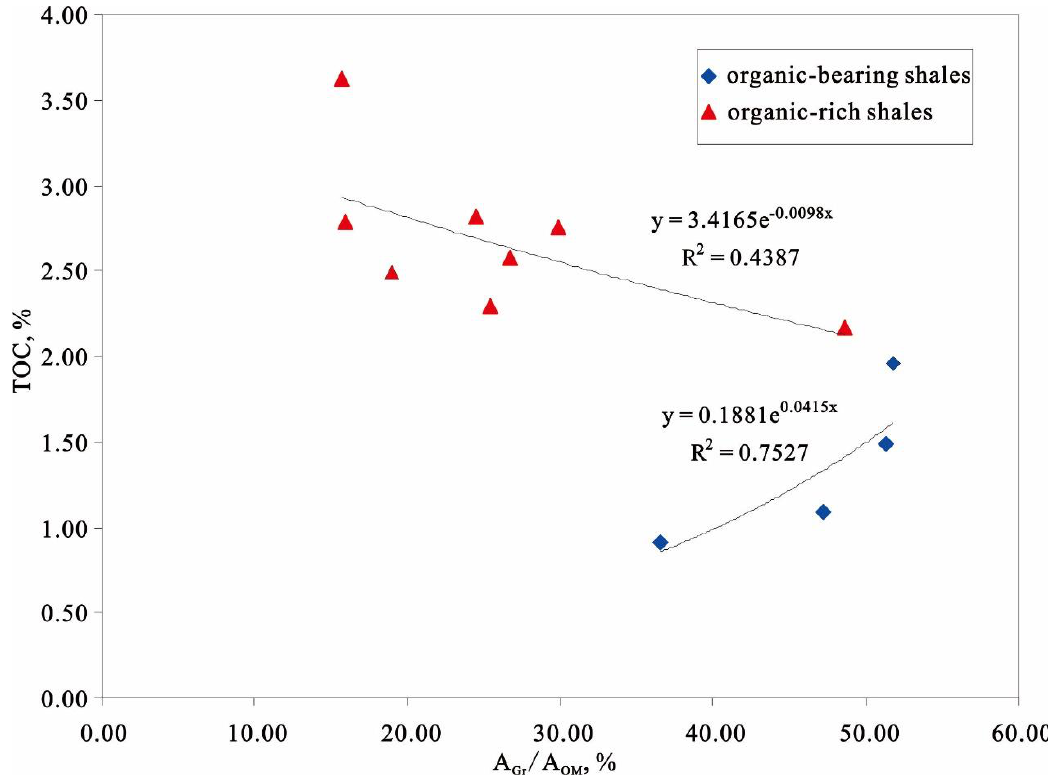
Figure 6. Correlation between the areal contribution rate of graptolites and TOC value. A Gr , graptolite area; A OM , area of organic matter.